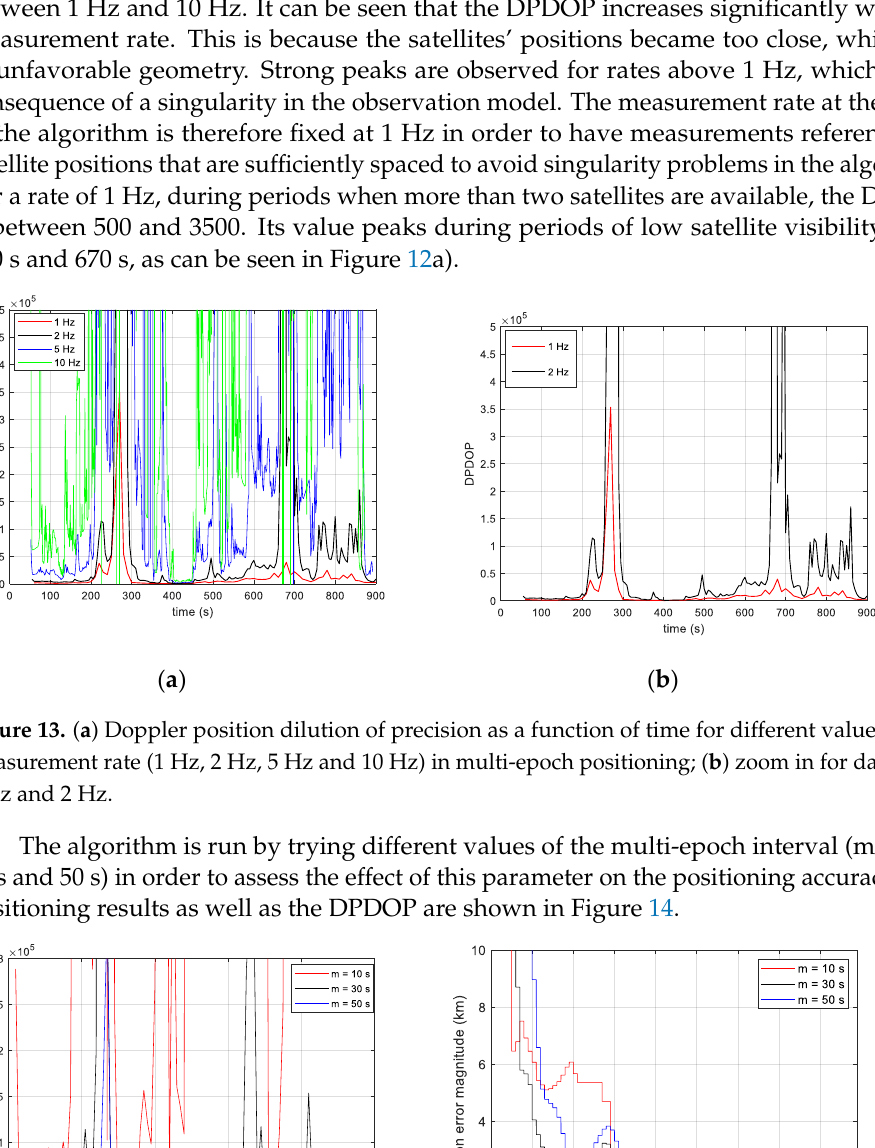
( b ) Figure 12. ( a ) Number of tracked satellites as function of time; ( b ) satellites ’ elevation angles at measurement epochs.